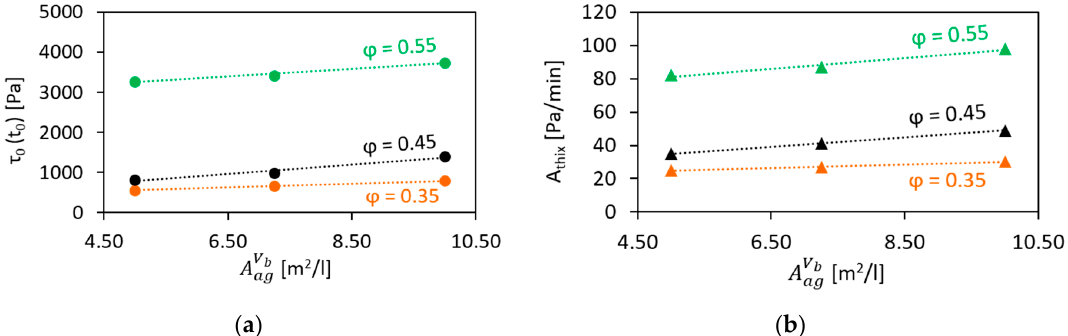
Figure 6. Effect of the surface area of aggregates per unit volume of cement paste on ( a ) the initial SYS and ( b ) the structural build-up rate of concrete.